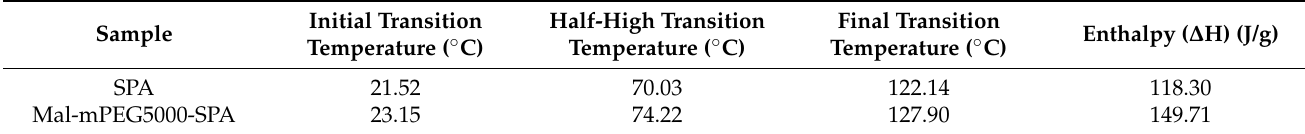
Table 1. Temperature changes in SPA and